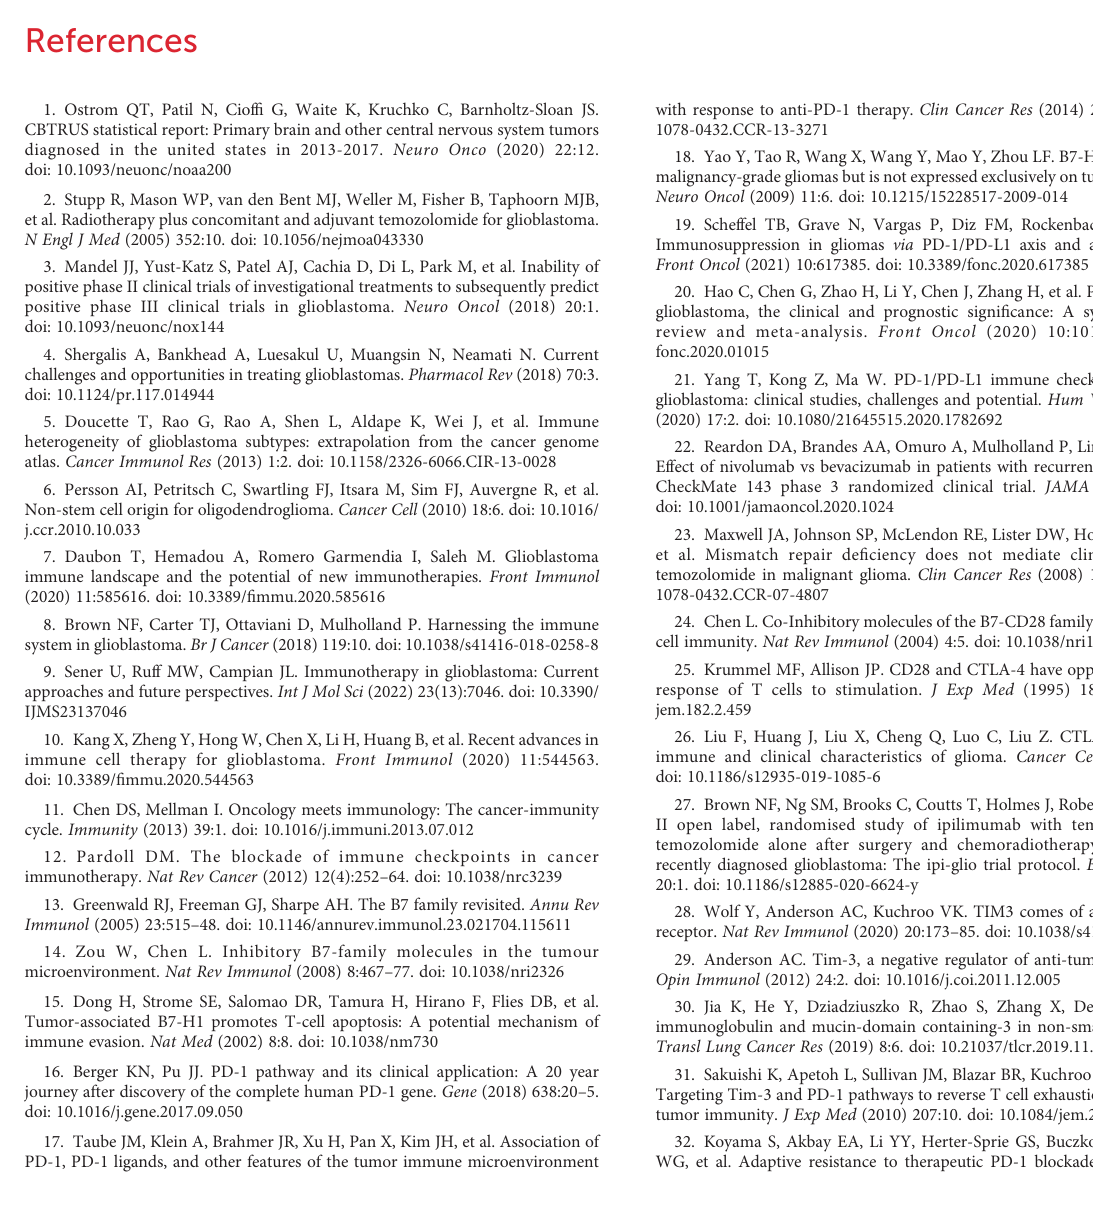
SUPPLEMENTARY TABLE 1 Clinical trials of checkpoint inhibitors for the treatment of GBM. SUPPLEMENTARY TABLE 2 Completed clinical trials of oncolytic virotherapy for the treatment of GBM. SUPPLEMENTARY TABLE 3 Currently active and/orrecruitingclinical trials ofoncolytic virotherapy for the treatment of GBM. SUPPLEMENTARY TABLE 4 Currently active and/or recruiting clinical trials of CAR-T cell therapy for the treatment of